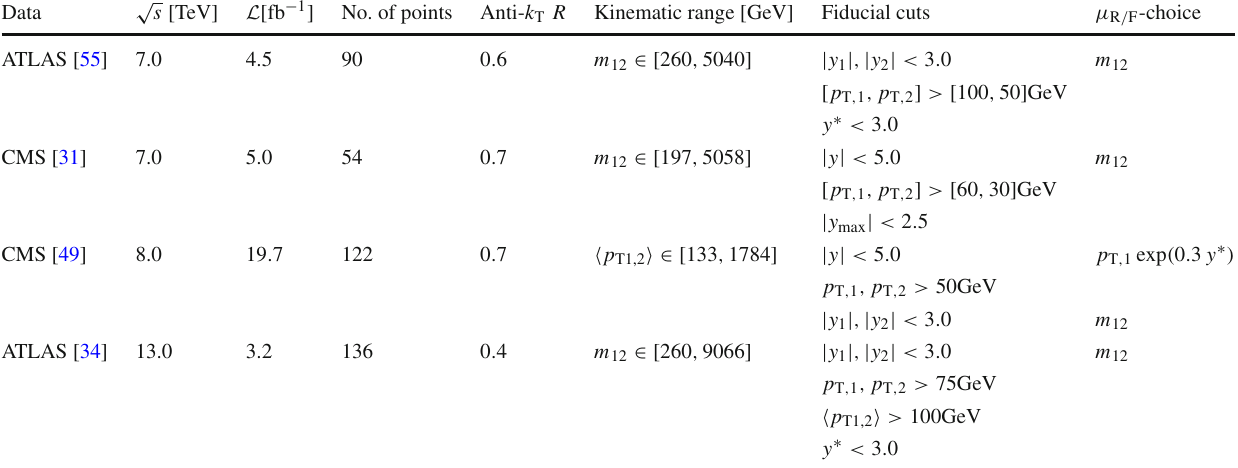
Table 2 An overview of dijet datasets with APPLfast interpolation fulfil the requirements with respect to their rapidities y 1 , y 2 and trans- verse momenta p T , 1 , p T , 2 . In addition, the choice of scale for μ R / F in grids for proton–proton collisions at the LHC. For each dataset the √ s , the integrated luminosity L , the number of centre-of-mass energy the interpolation grids is data points, and the jet algorithm are listed. The two leading jets must